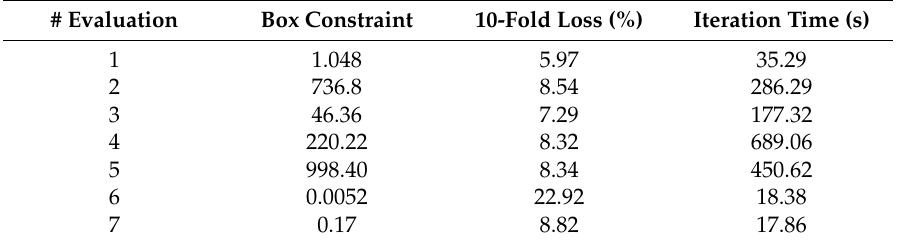
Table 2. Box constraint (C) parameter optimization using 10-fold cross-validation loss